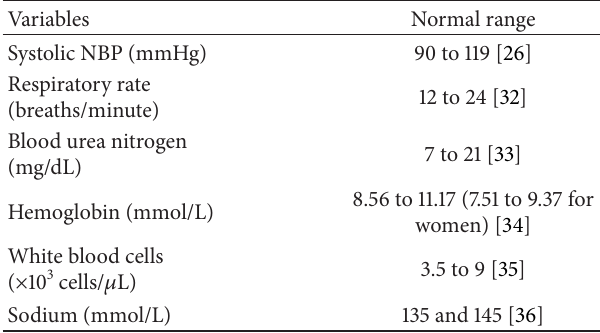
Table 4: Normal range of values for each physiological